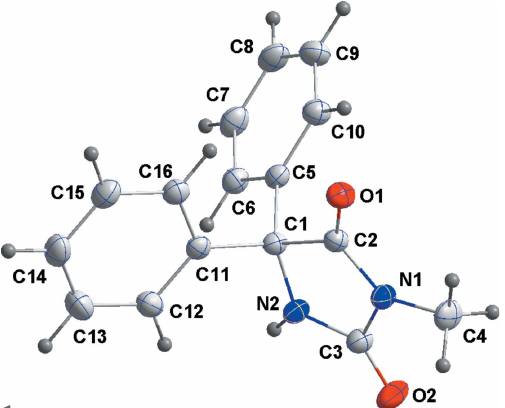
Table 1 Hydrogen-bond geometry (A˚ , (cid:2) ).